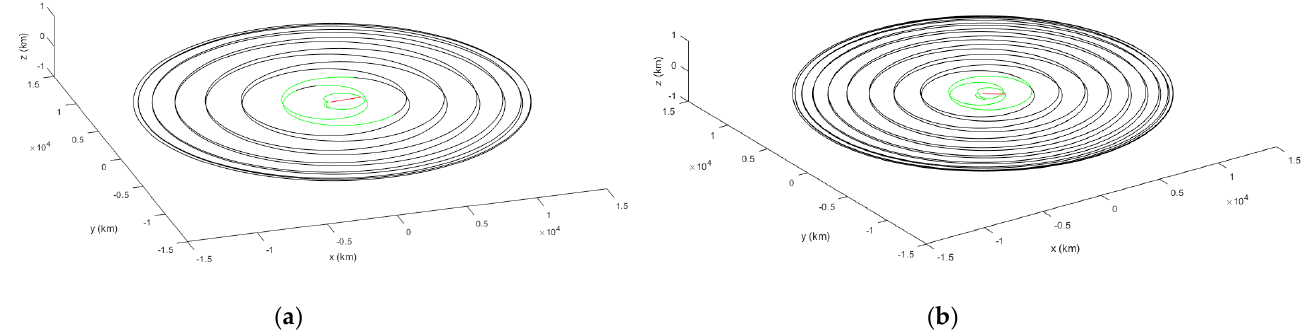
Figure 2 (a) Case 2 and (b) Case 4 show the respective relative orbits. We use different colors (green and black) to indicate if there is a clear line of sight between S and D or if the objects are eclipsed by the Earth . The small red segments S-D show the connecting line between S and D at the p-N shooting instants.